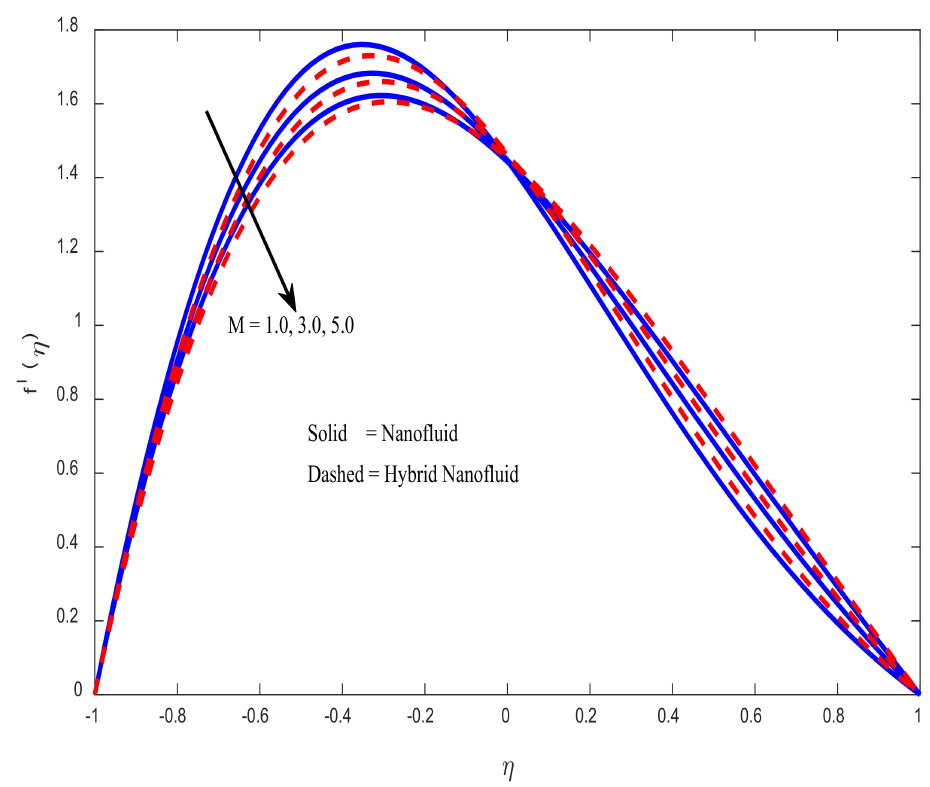
Figure 4. Influence of M on the velocity